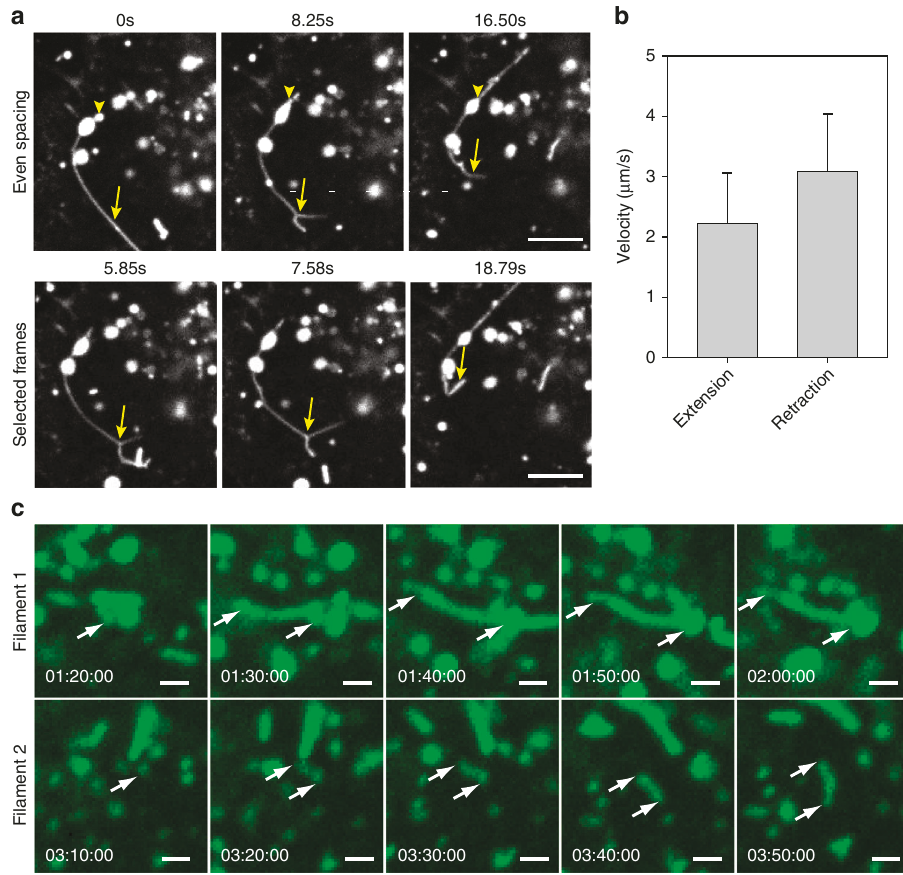
Fig. 6 RSV fi laments are formed by a rapid vesicular extension and retraction motion. a Vero cells were infected with RSV A2 at an MOI of 1. At 16 hpi, SBA-488 was delivered and allowed to internalize for an hour. Cells were then imaged live at 12.13 Hz. Time series are shown with either even temporal spacing ( top ) or as selected frames from the movie ( bottom ). Yellow arrowheads indicate distension of vesicles, while arrows indicate extended fi laments and branched fi laments. Scale bar represents 5 µ m. b Individual extension and retraction events were analyzed by hand on a frame-by-frame basis to determine the mean velocity. 30 events of each type were analyzed. Error bars represent standard deviation. c Vero cells were infected with RSV A2 at an MOI of 1. After 12 h, SBA-488 ( green ) was delivered to the cells and allowed to internalize for 1 h before being imaged every 10 min. Cropped regions of two individual fi laments are shown. Yellow arrows mark the two apparent ends of the fi laments. Scale bars represent 1 µ